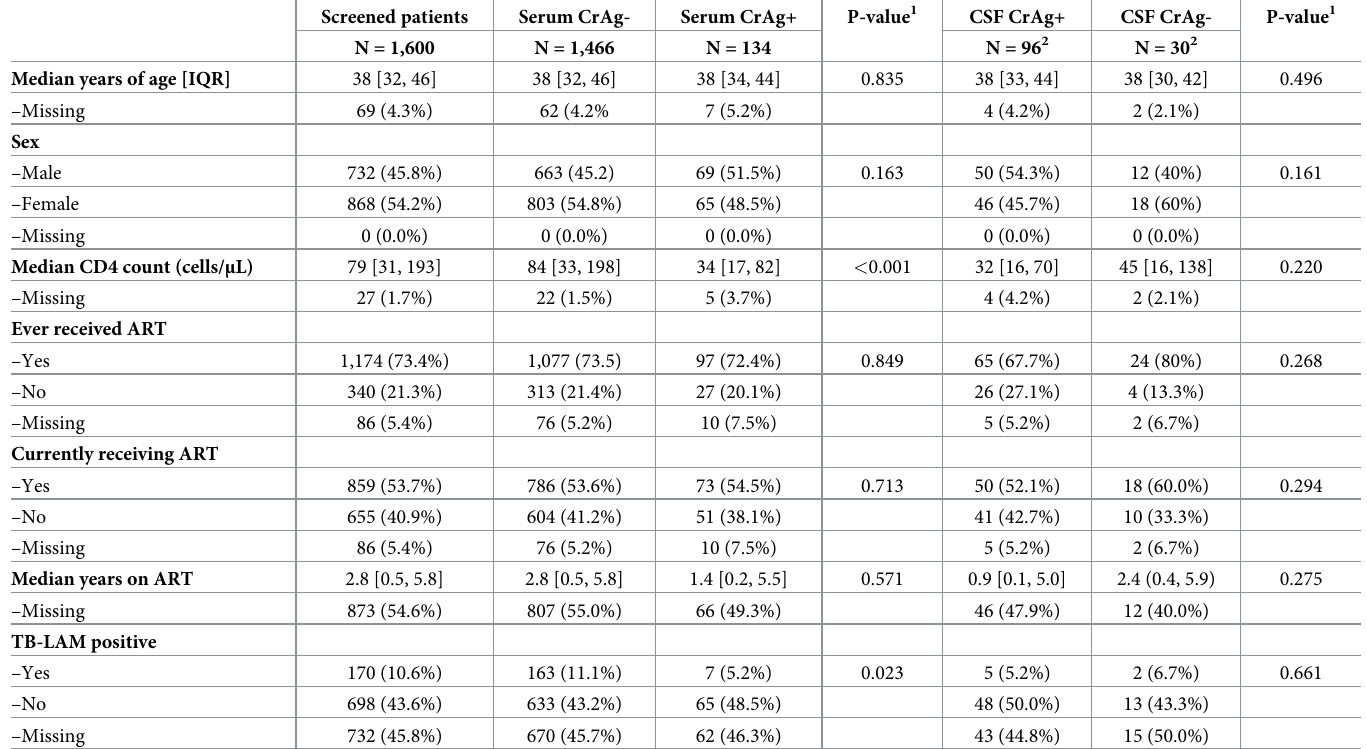
Table 1. Baseline characteristics and demographics of patients with cryptococcal antigenemia and meningitis.